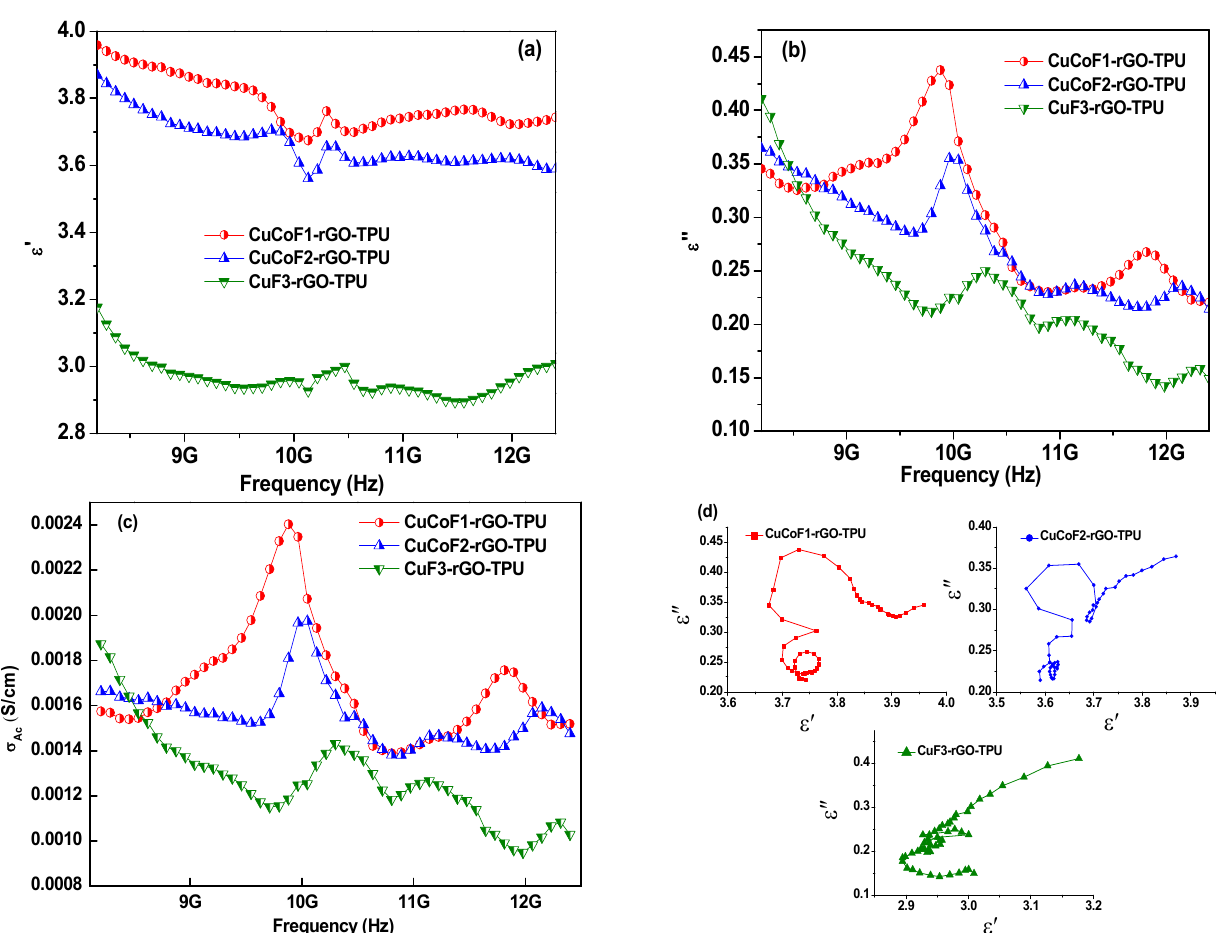
Figure 8. ( a ) the real part ( ε′ ) ( b ) the imaginary part ( ε″ ) of permittivity ( c ) ac conductivity ( σ ac ) versus frequency, and ( d ) Cole-cole plots for CuCoF1, CuCoF2 and CuF3 nanoparticles based nanocomposites along with rGO in TPU matrix.